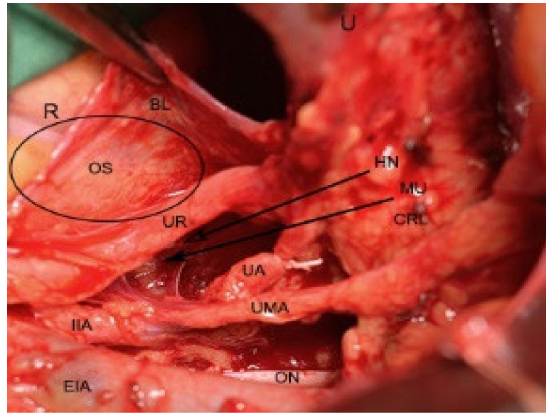
Figure 7. Development of Okabayashi’s space during open surgery (right side of the pelvis). The ureter and mesoureter are separated from the posterior leaf of broad ligament.